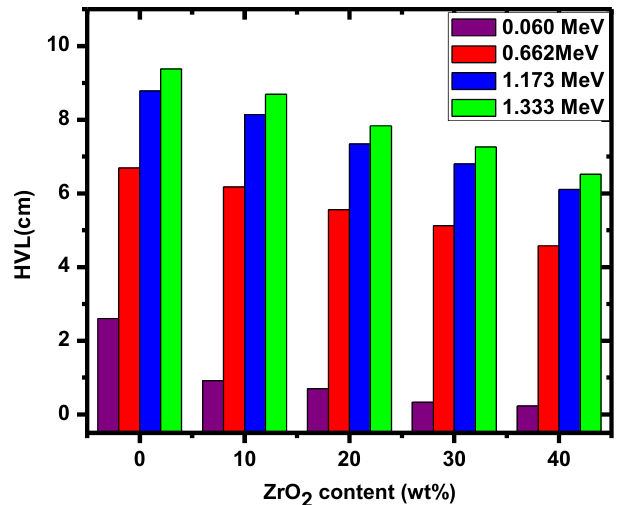
Figure 5. The variation of the half value layer values of epoxy with ZrO 2 .